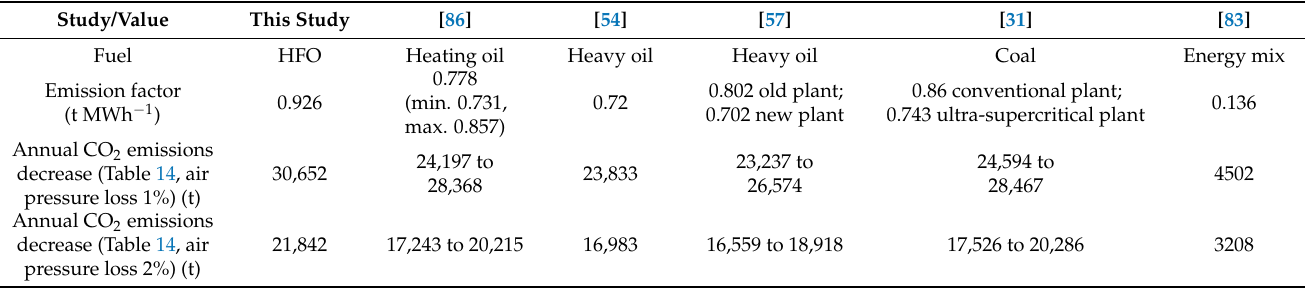
Table 15. Decrease in annual emissions of CO 2 resulting from ACH